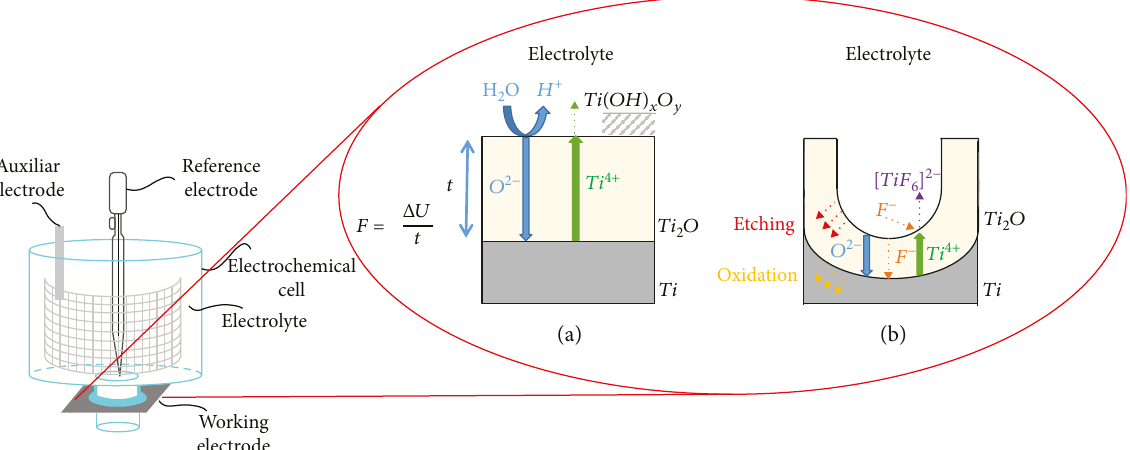
Figure 5: Anodization process representation in (a) absence of fl uoride electrolyte and (b) presence of fl uoride electrolyte.